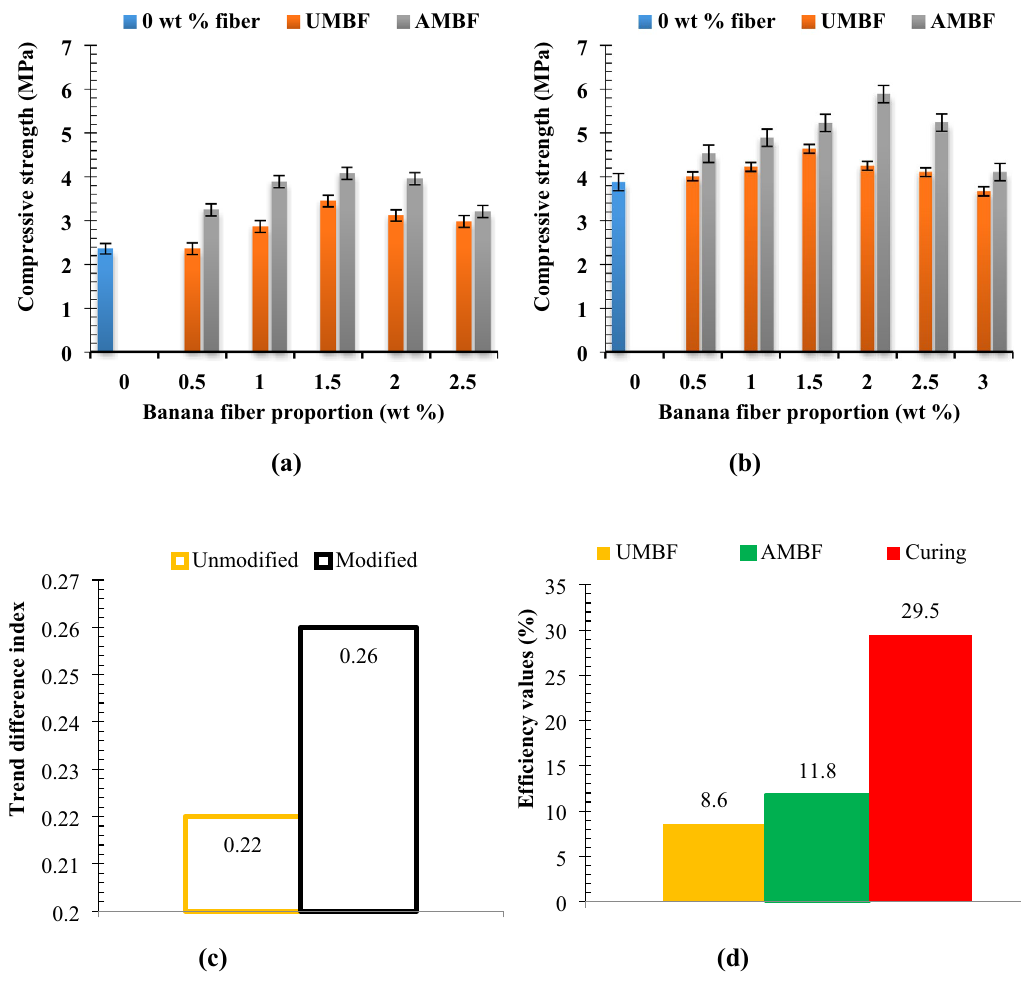
Figure 6. Relation between fiber proportion of unmodified and modified fiber on compressive strength at curing days of ( a ) 28 days and ( b ) 56 days with ( c ) experimental trend analysis and ( d ) property evaluation of experimental